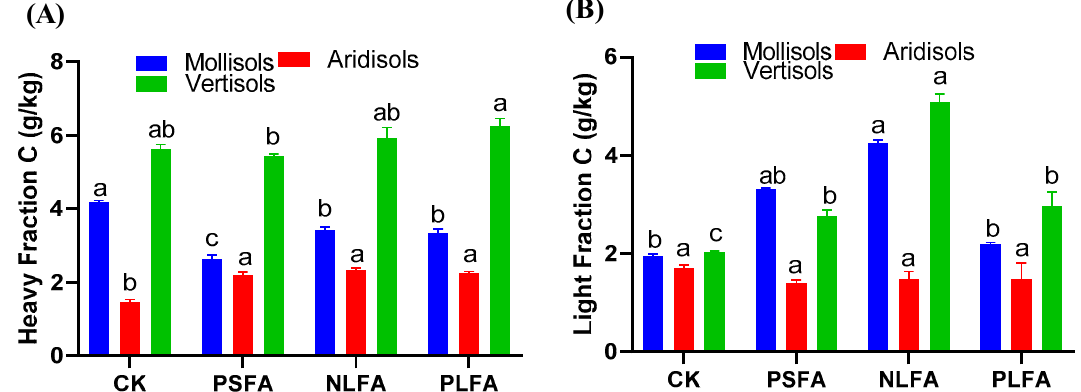
Figure 2. The effect of plant-derived solid fulvic acid (PSFA), mineral-derived liquid fulvic acid (NLFA), and plant-derived liquid fulvic acid (PLFA) on ( A ) heavy fraction C and ( B ) light fraction C content of Mollisols, Aridisols, and Vertisols soils. The means ± standard errors are shown ( n = 4). Different letters (a, b, and c) indicate significant differences between the initial and final values of the soils based on a least significant difference test at a 5% significance level.